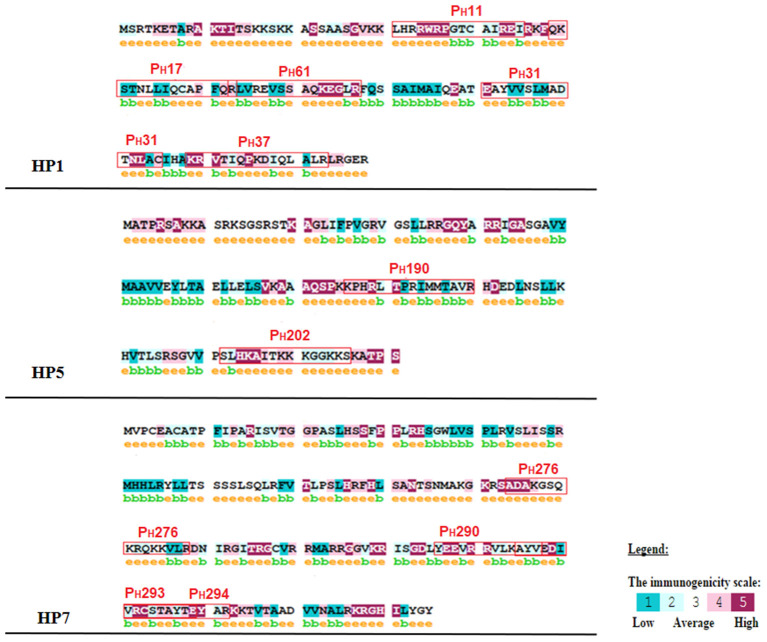
Immunogenicity analysis of the reactive peptides. The letter e, in yellow and above amino acids, indicates a predicted exposed residue. The letter b, in green and above amino acids, indicates a predicted buried residue. A color scale indicates the immunogenicity of each amino acid, which is present in the figure. The immunogenicity was classified as 1 for low and 5 for high for each amino acid.